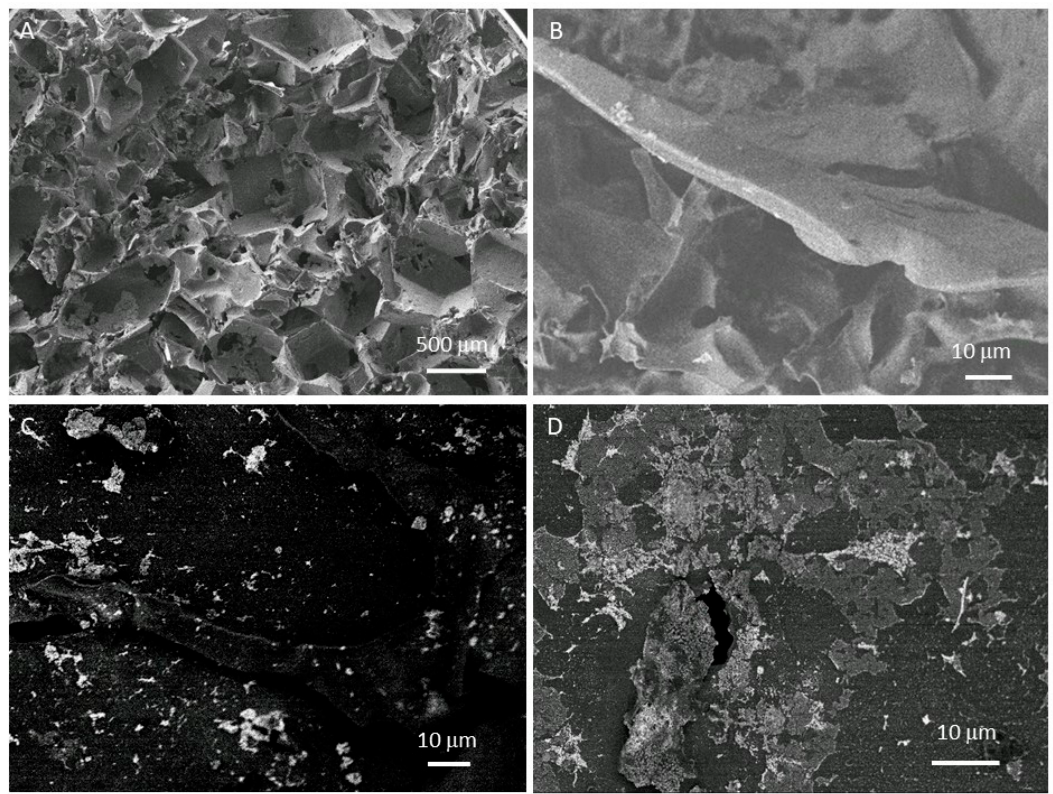
Figure 1. Representative SEM micrographs of PDMS sponges doped with gold nanoparticles. ( A , B ) Secondary electron analysis shows the morphology and high porosity of the PDMS sponges. ( C , D ) Backscattered electron analysis shows the presence of gold nanoparticles as bright spots.